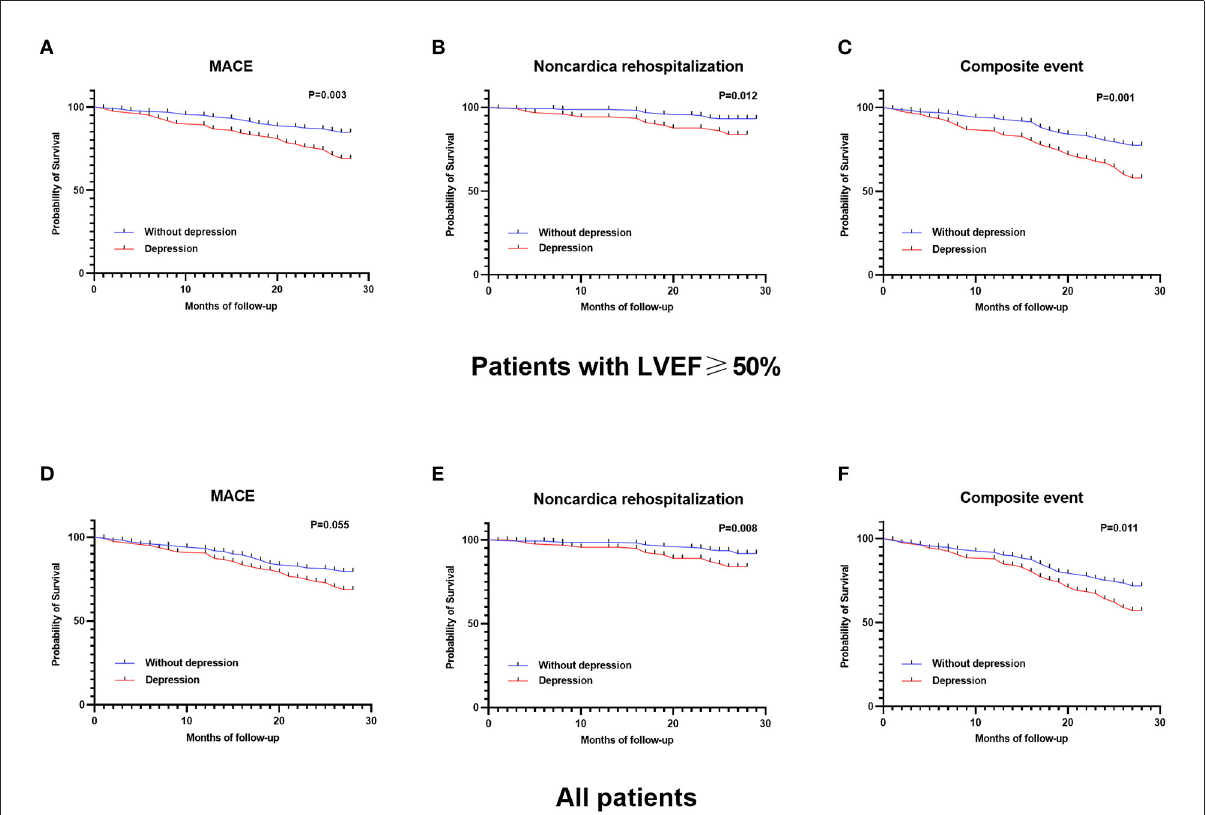
FIGURE2 Kaplan–Meier survival analyses of depression in patients with LVEF ≥ 50% for (A) MACE, (B) non-cardiac rehospitalization, (C) composite event, and in all patients for (D) MACE, (E) non-cardiac rehospitalization, and (F) composite event. The prognostic value of depression on all clinical outcomes were more significant in patients with LVEF ≥